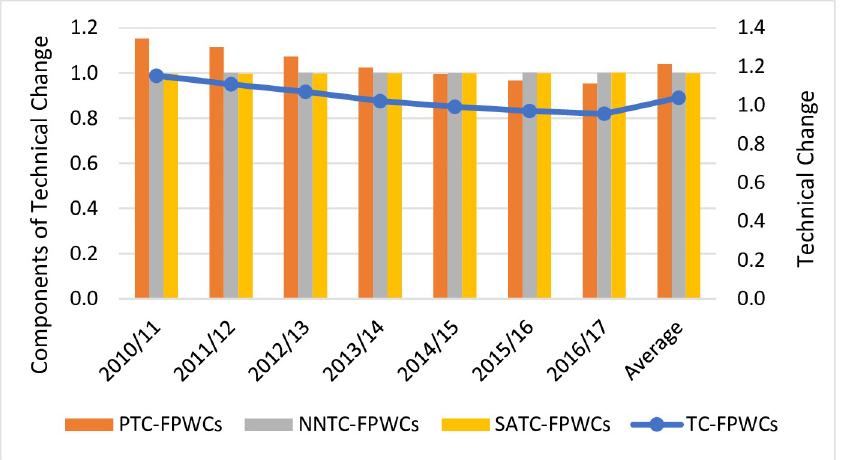
Fig 3. Technical Change (TC) estimations and its components (pure technical change -PTC-, non-neutral technical change -NNTC and scale-augmenting efficiency change -SATC-) for Chilean full private water companies